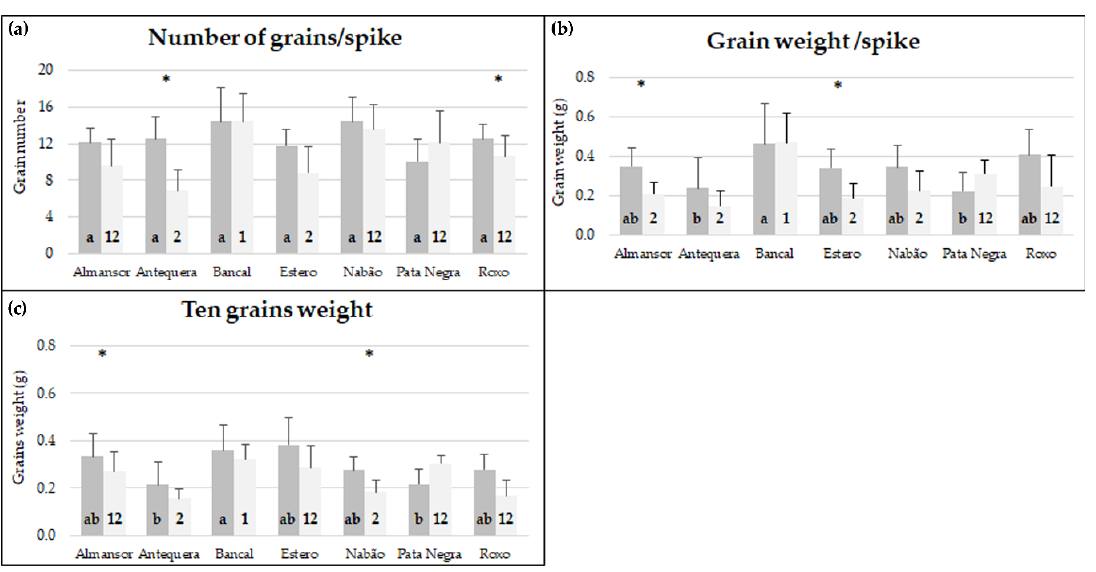
Figure 1. Number of grains/spike ( a ), grain weight/spike ( b ), and ten grains weight ( c ) of plants kept in control conditions (dark gray) and high temperature treatment (light gray). Means ± standard deviation (represented as bars). Different letters (control) and numbers (treatment) inside bars indicate ANOVA significant differences between varieties detected by multiple means comparison test. (*) indicates t -test statistical differences between control and treatment in each variety ( p < 0.05).